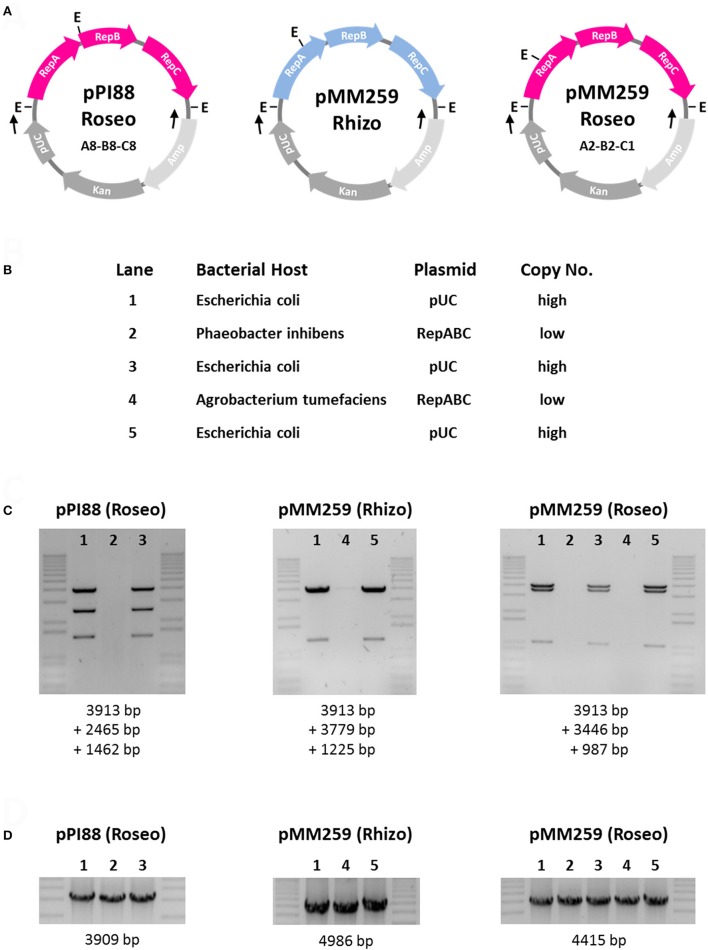
Functionality tests of rhizobial and rhodobacteral RepABC-type plasmids in Phaeobacter inhibens DSM 17395 and Agrobacterium tumefaciens C58. (A) Schematic plasmid maps of the tested constructs. Roseobacter and rhizobial RepABC-type replication systems are shown in pink and blue, respectively. The genes of the cloning vector pCR2.1 are shown in gray. pUC, origin of replication; Kan and Amp, kanamycin and ampicillin resistance genes; E, EcoRI restriction site; Black arrows indicate primer binding sites for PCR amplification. (B) Specificity and copy number of composite plasmids based on the host range of the plasmid replication system. (C) Plasmid restriction assay with EcoRI. The 1 kb Plus DNA ladder from Invitrogen was used as a marker. (D) PCR assay with pCR2.1-specific primers.